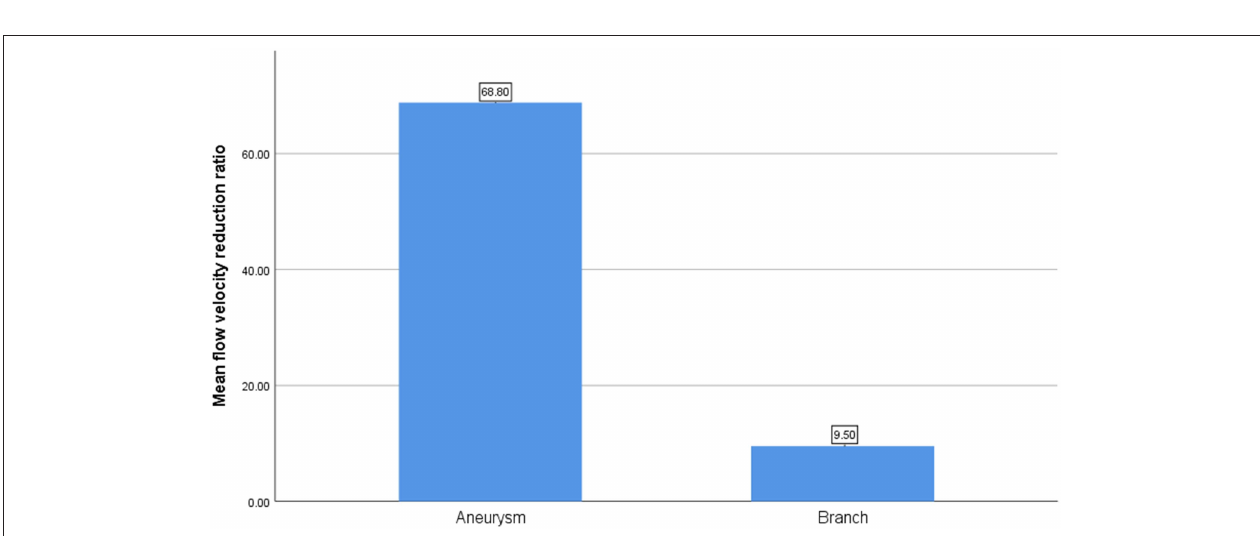
FIGURE 3 | The comparison of mean flow velocity reduction ratio between aneurysm and branch.